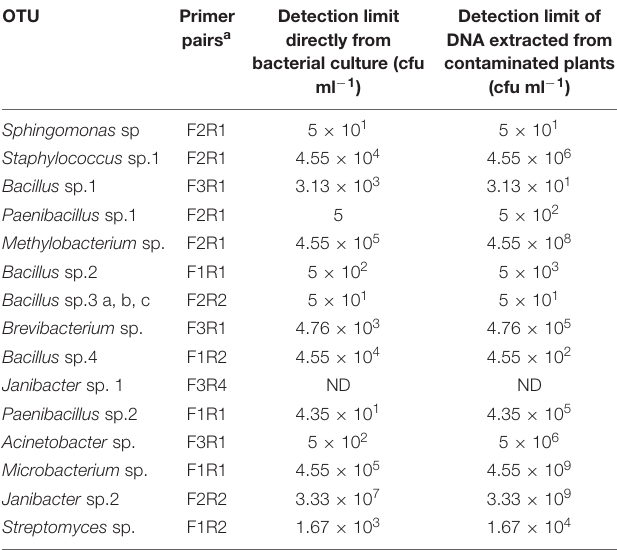
TABLE 5 | Sensitivity of primers for detecting each bacterial group